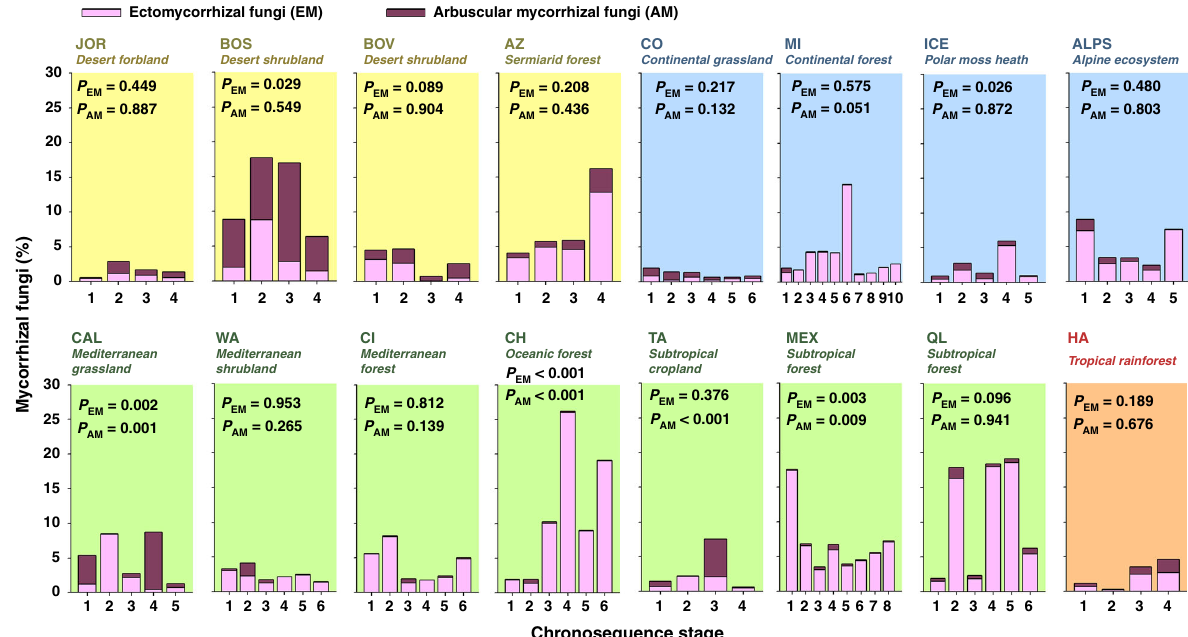
Fig. 8 Changes in mycorrhizal community structure during ecosystem development. Mycorrhizal fungi (mean values) = %. PERMANOVA P -values are shown. Chronosequence stage was included as a fi xed factor in these analyses ( n = material, climate and vegetation type, rather than soil age, play dominant roles in driving the values and long-term temporal trajectories structure and function of terrestrial ecosystems across biomes. For example, irrespective of soil age, drylands, and non- forested ecosystems consistently had lower measures of ecosystem function, and weaker increases in plant productivity over time, than did more mesic and forested ecosystems. Thus, variation in environmental contexts that result from global change factors, including shifts in precipitation, temperature, and vegetation, may substantially modify the conditions under which ecosystems develop, and slow down the longer-term development of terres- trial ecosystems in a drier, hotter and less-forested world 19,20 .